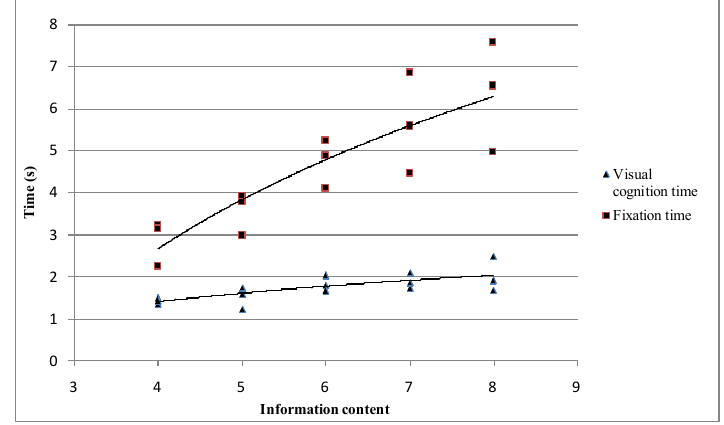
Fig.8. Correlation between cognition time and fixation time under different information